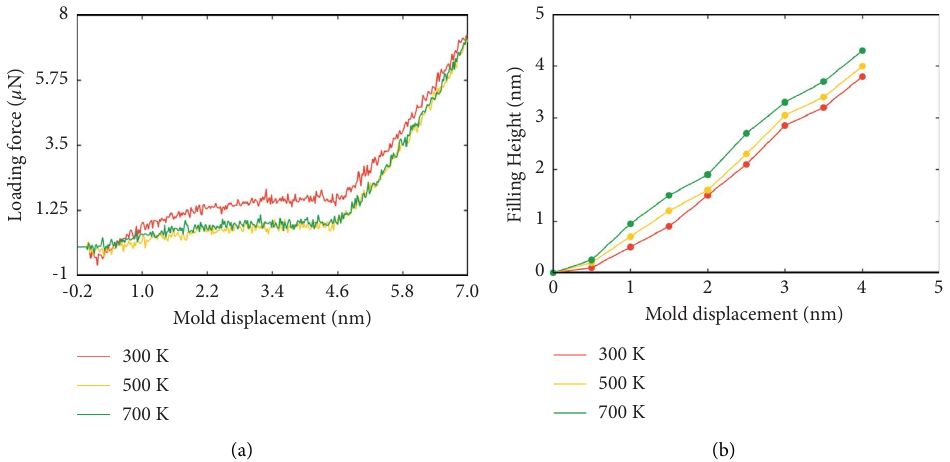
Figure 4: (a) Loading force and (b) flling height as a function of mold displacement for the tip-like pattern imprinting